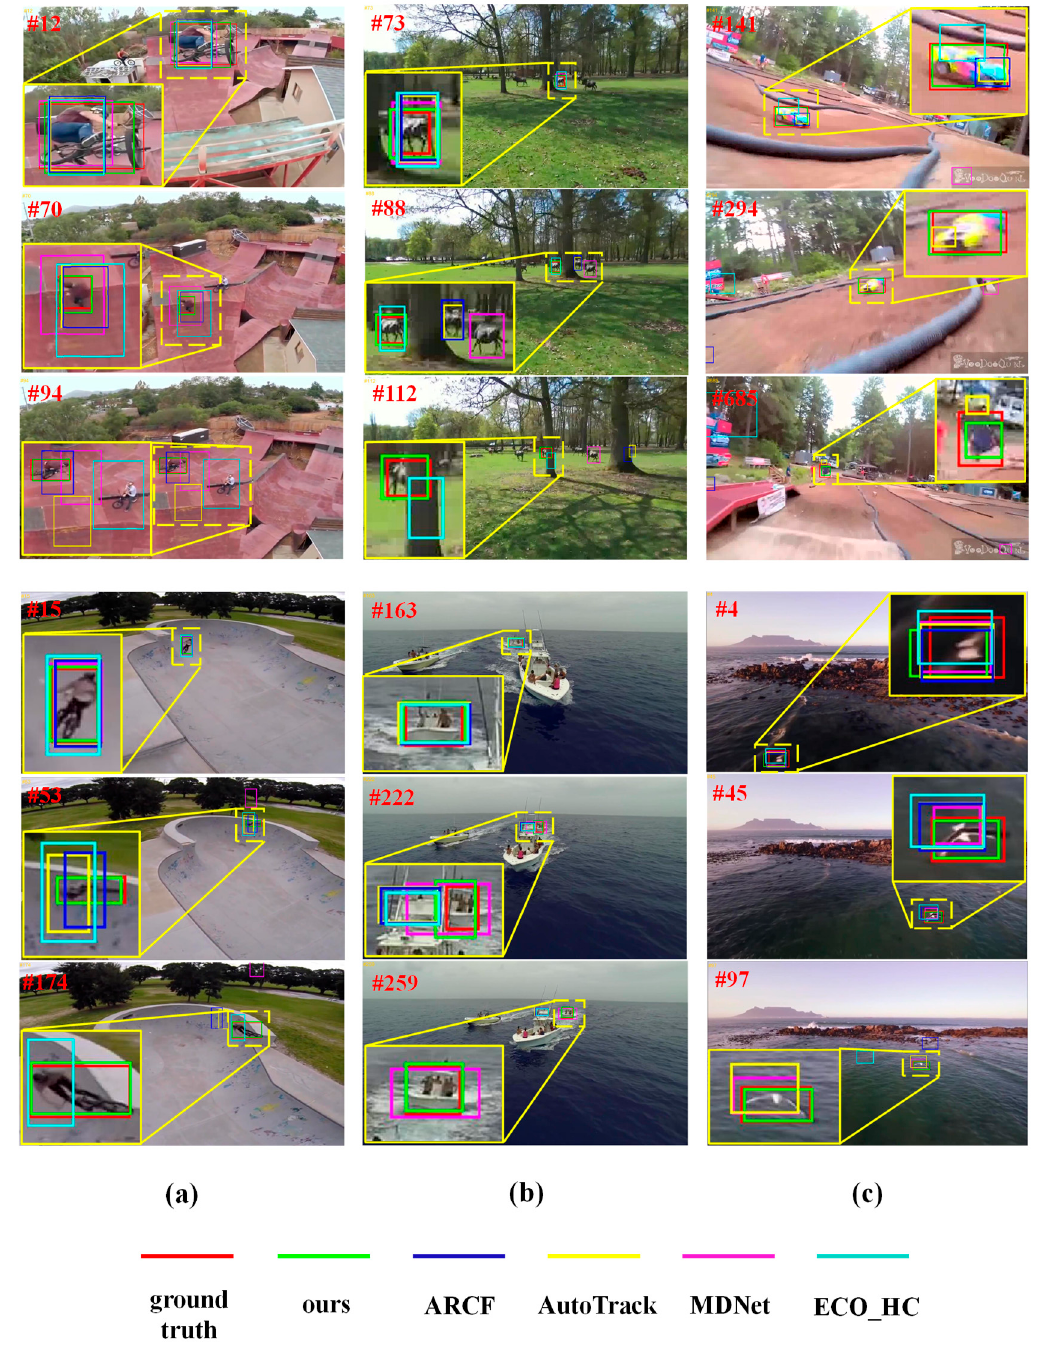
Figure 7. Tracking results of the proposed tracker and other state-of-art trackers on the DTB70 dataset. From top to down and left to right are the screenshots of the tracking results on the videos of BMX3 , BMX5 , Hours1 , Yatch4 , RcCar4 , and GULL1 . The video sequences in ( a ), ( b ) and ( c ) mainly involve SV, ARV and IPR, OCC and SOA, MB, BA and FCM,